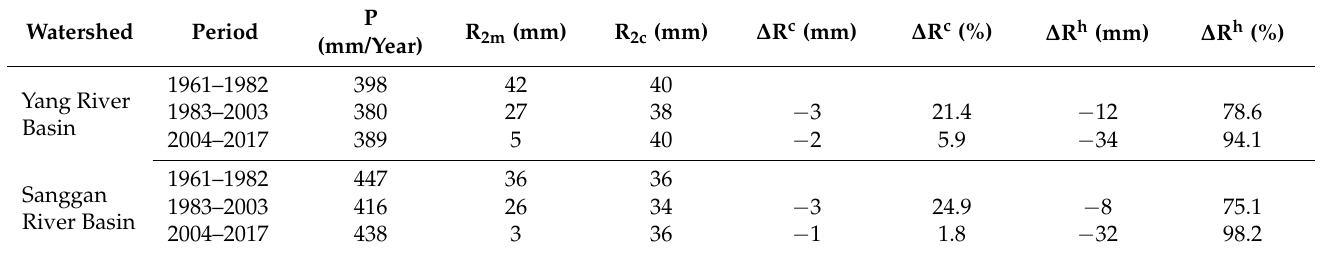
Table 3. Climate change and human activities on streamflow in the UYRB by the the DMC